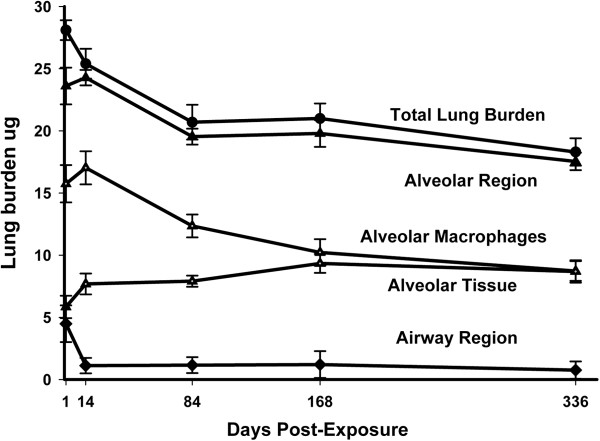
Changes in the distribution of MWCNTs in the lungs after inhalation exposure to MWCNTs. Changes in the lung burden are given for total lung burden, the airway region and the alveolar region. Burden in the alveolar region is further subdivided into that present in alveolar macrophages and that in alveolar tissue (including MWCNTs in subpleural alveolar tissue). Between day 1 and 14 days post-exposure the burden in the airway region rapidly declined to a near steady level for the remainder of the post-exposure period. The burden in the alveolar region paralleled the total lung burden with the small difference being due to that present in the airway region. Burden in alveolar macrophages was initially 3 fold higher than burden in the alveolar tissue but was nearly equal by 336 days post-exposure as the burden in alveolar macrophages declined and the burden in alveolar tissue increased. Data Mean ± S.E., N = 5.